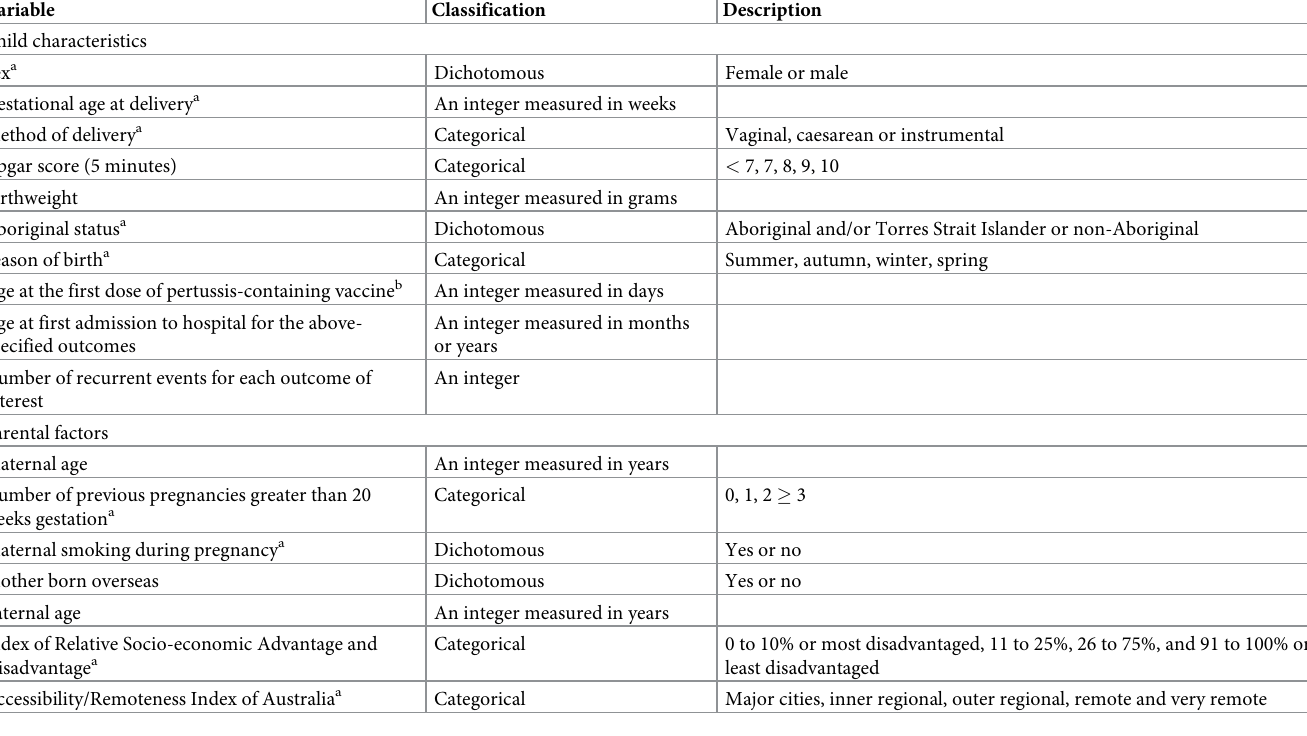
Table 2. Variables that will be included in the description of the cohort. Variable